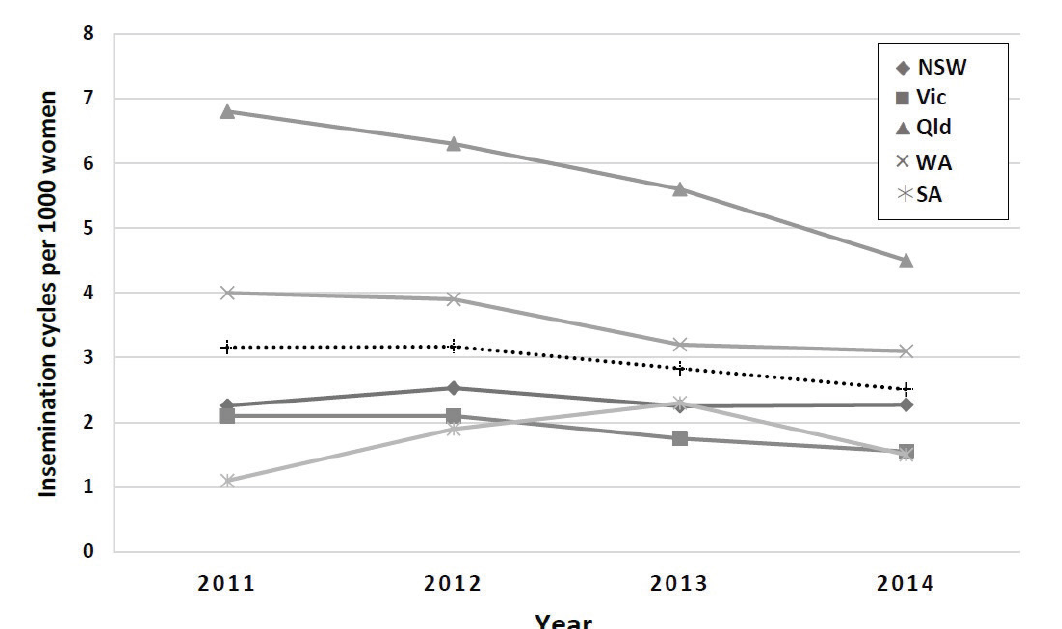
Figure 3. Age-stratified incidence rate of intrauterine insemination (IUI) cycles in women aged 24 to 34 years in Australia (cycles per 1000 women per year), 2011 to 2014 inclusive